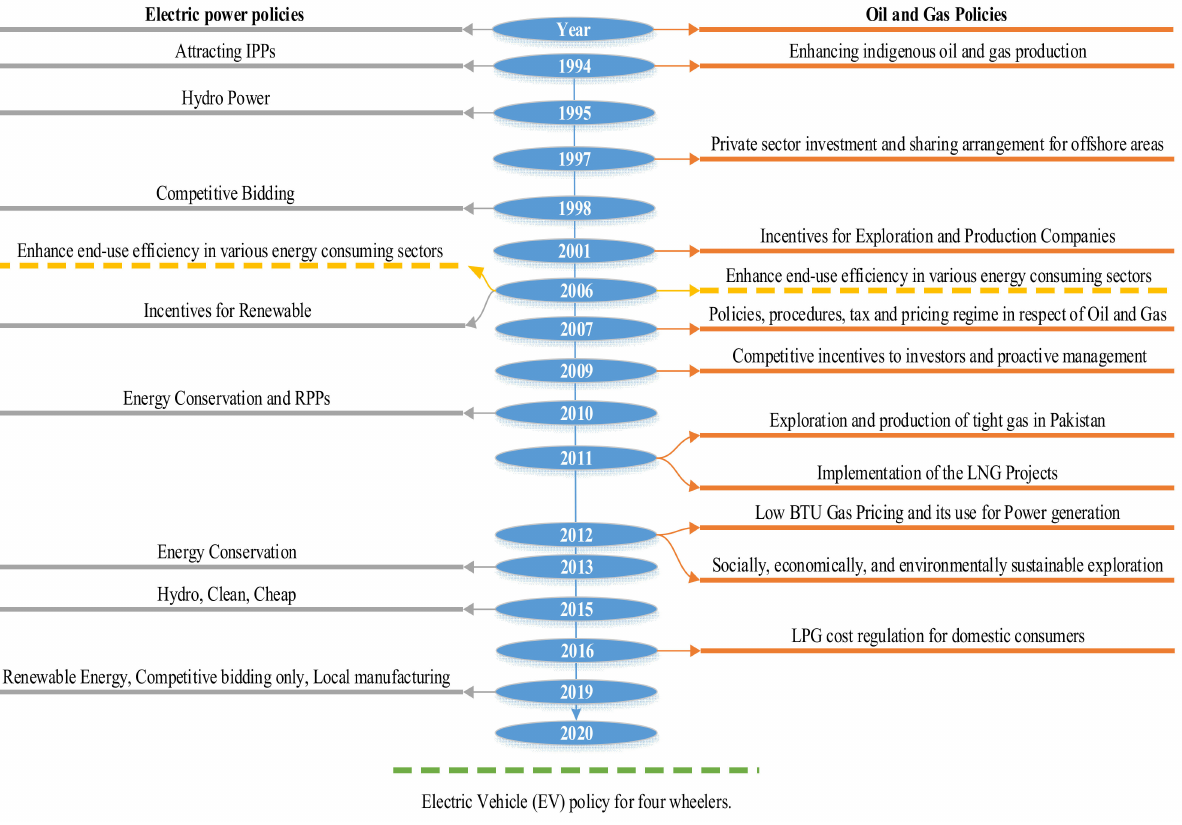
Figure 7. Energy and power policies and